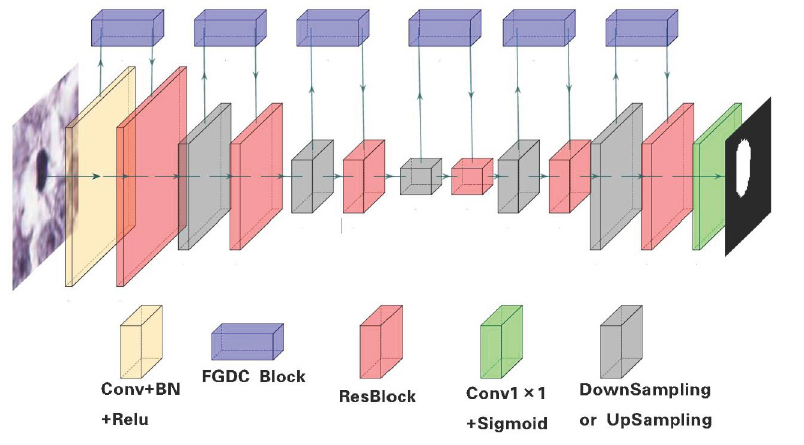
Fig 4. Workflow of image segmentation through FGDC-net.